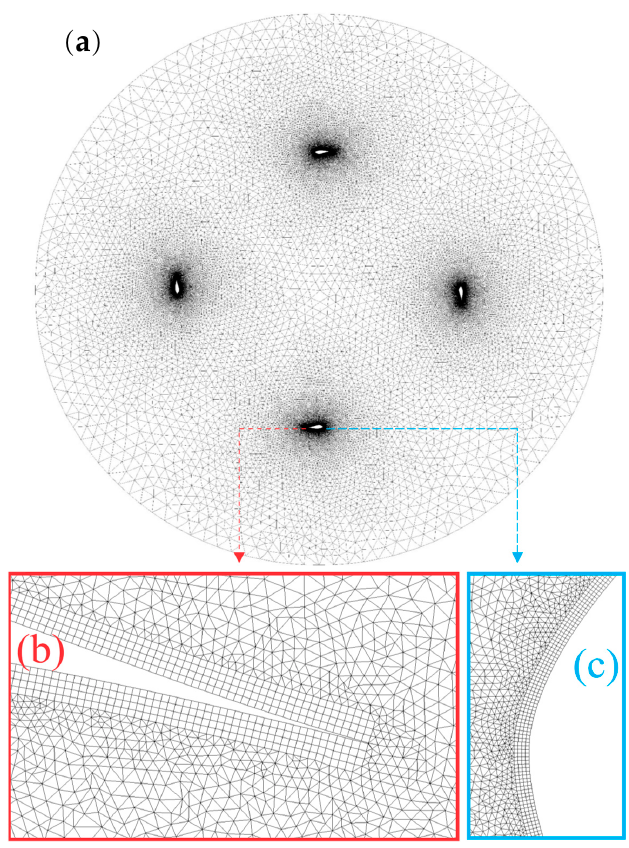
Figure 3. VAWT mesh around S815 airfoil: ( a ) rotating domain; ( b ) close view of trailing edge; ( c ) close view of the leading edge.